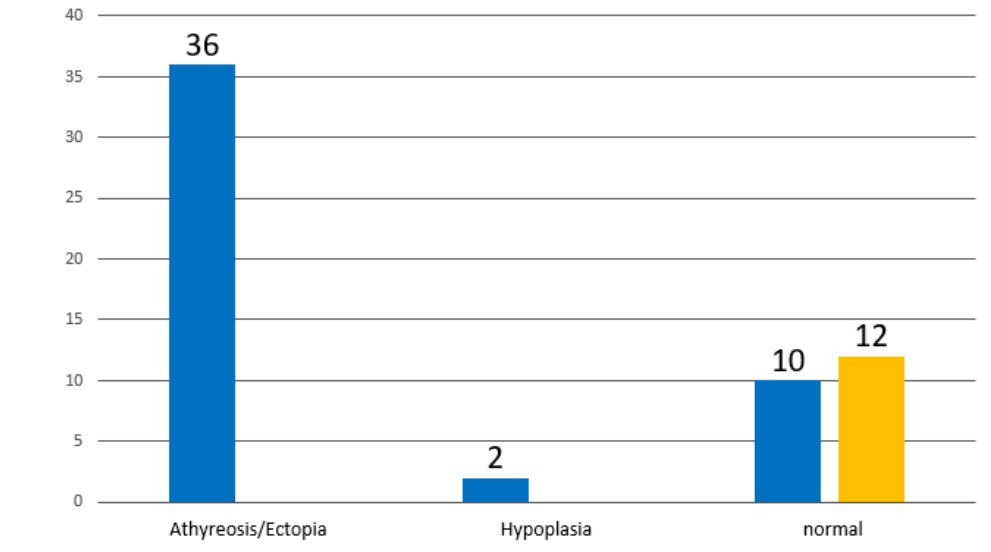
Figure 8. Distribution of diagnostic findings of thyroid sonography. ■ pCH ■ tCH. Table 5. Diagnostic findings of thyroid sonography. [n (%)].